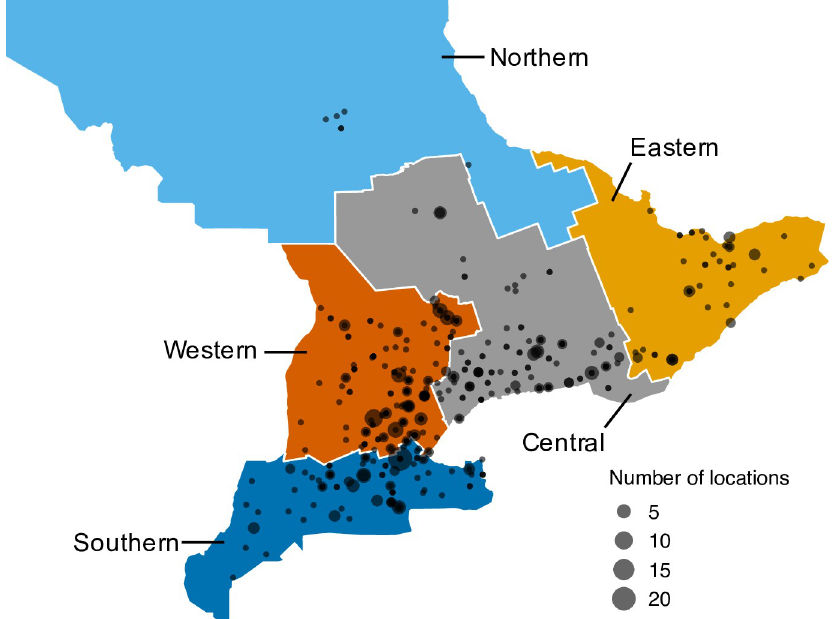
Fig 2. Locations in Ontario (n = 539) travelled by a sample of horses between May and November 2015. Colours represent agricultural census regions as defined by Statistics Canada. Point size represents the cumulative number of locations present in the same area.